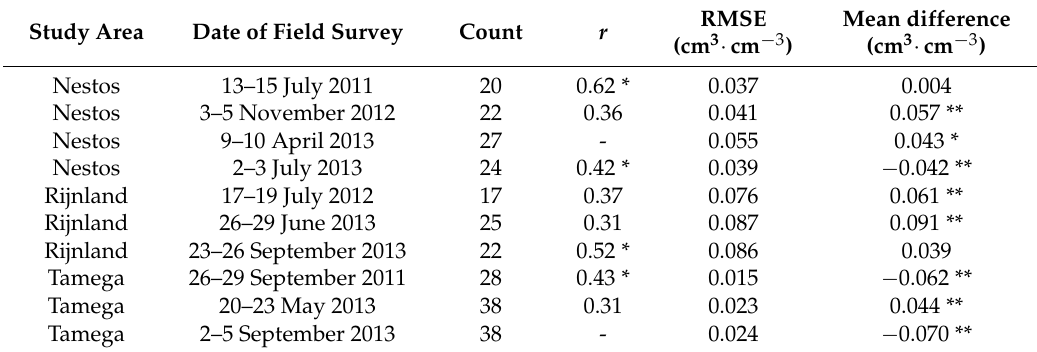
Table 4. Correlation coefficients, RMSE and mean differences of field-surveyed vs. remote sensing data. Study